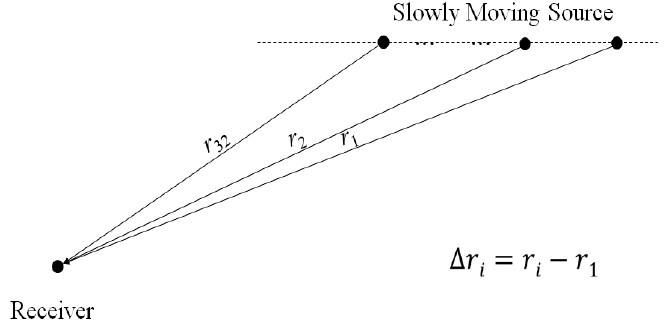
Figure 2. Sketch of experimental scheme .